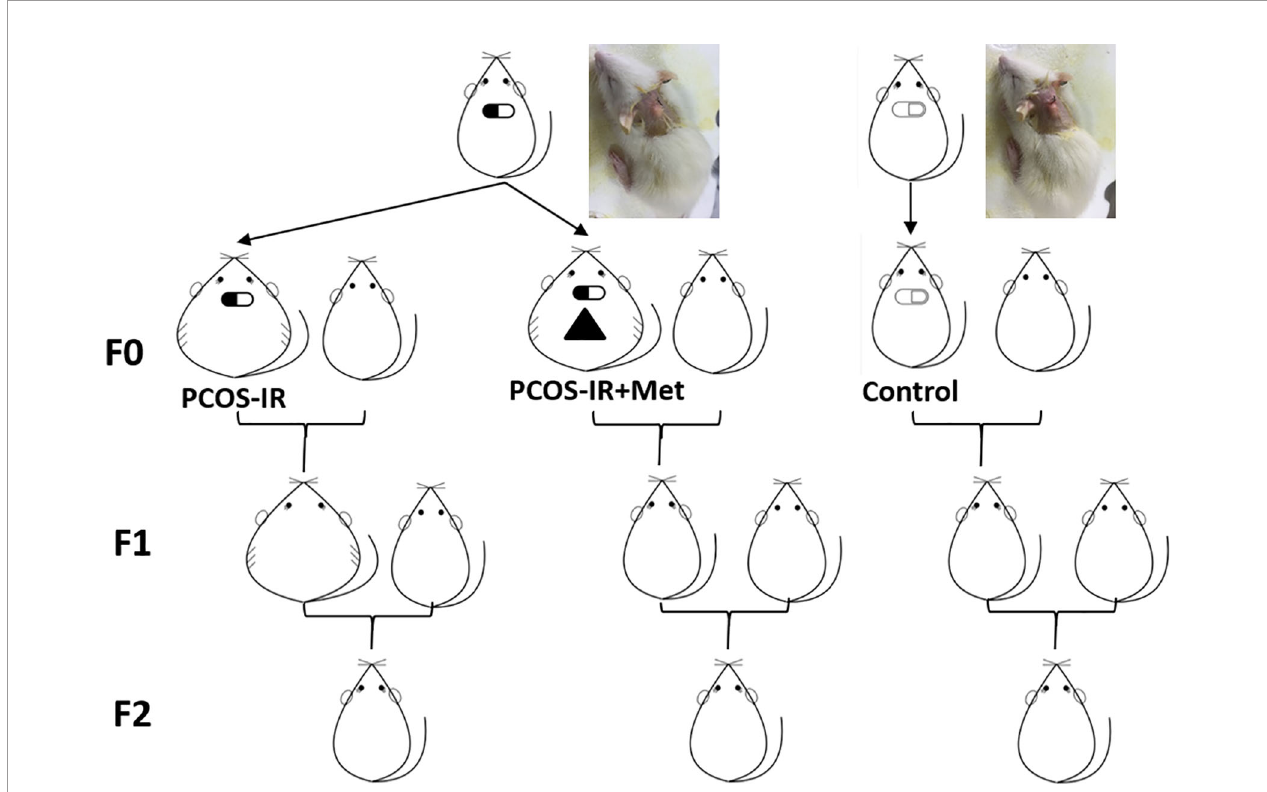
FIGURE 1 | Schematic representation of experimental design and grouping. Female rats were implanted with letrozole-continuous-release pellets to establish PCOS-IR rat model. F0 female rats were randomly divided into PCOS-IR+Met, PCOS-IR, and Control groups and crossed with healthy male rats to obtain F1 offspring. F1 female offspring crossed with healthy male rat to obtain F2